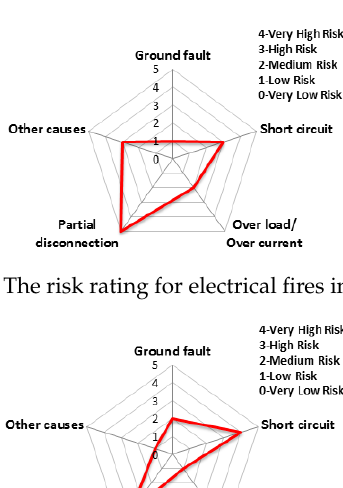
Figure 14. The risk rating for electrical fires in Daejeon.